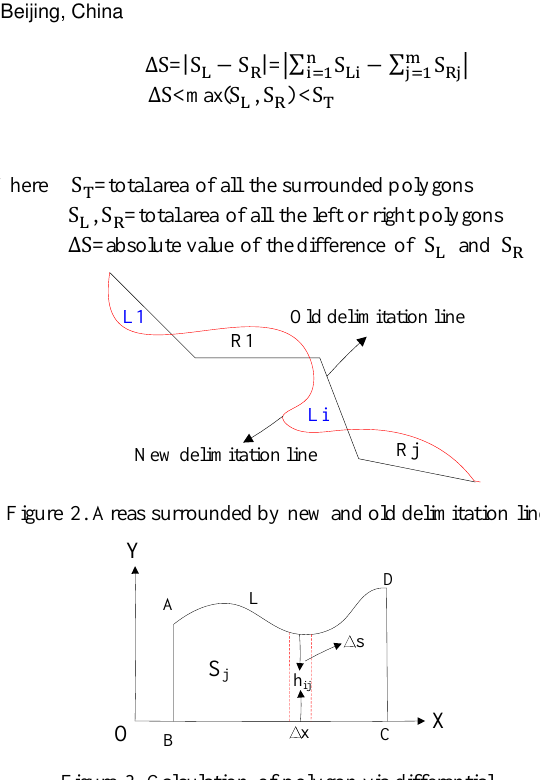
Figure 3. Calculation of polygon via differential extremum principle